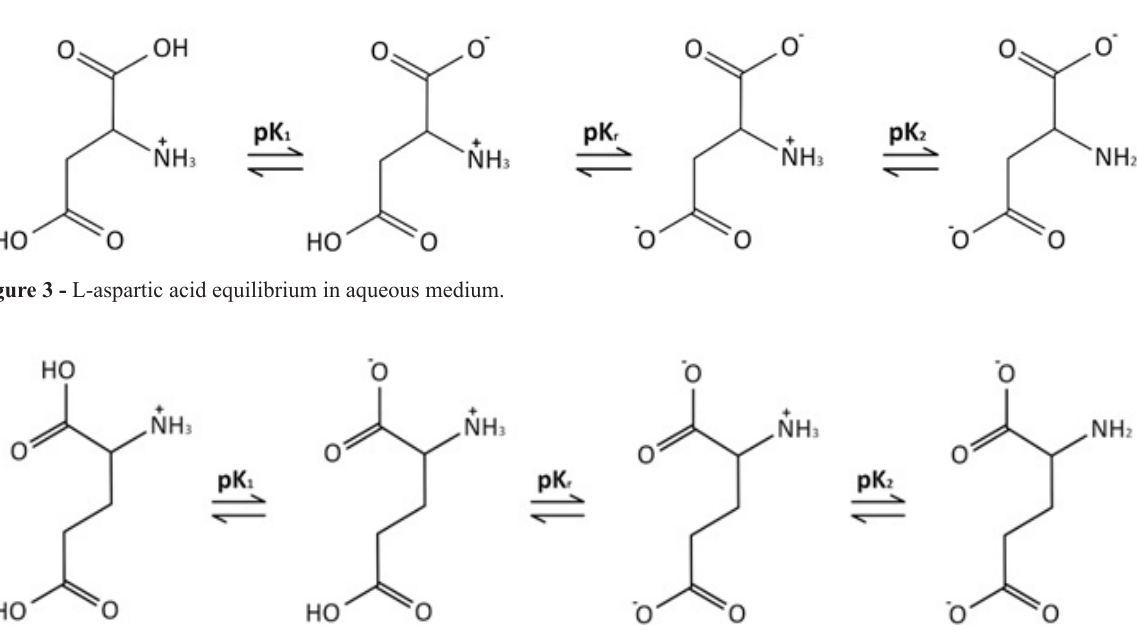
Figure 4 - L-glutamic acid equilibrium in aqueous